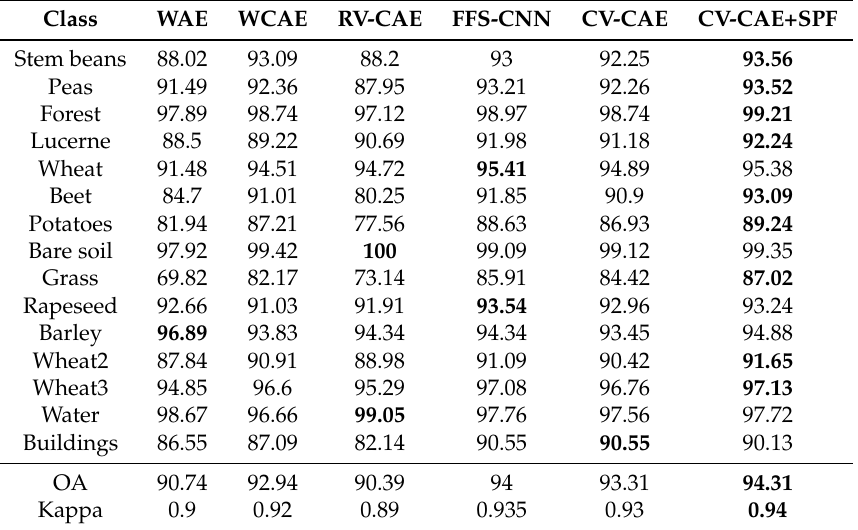
Table 5. The OA and Kappa Coefficient of Our Algorithms and the Compared Algorithms.